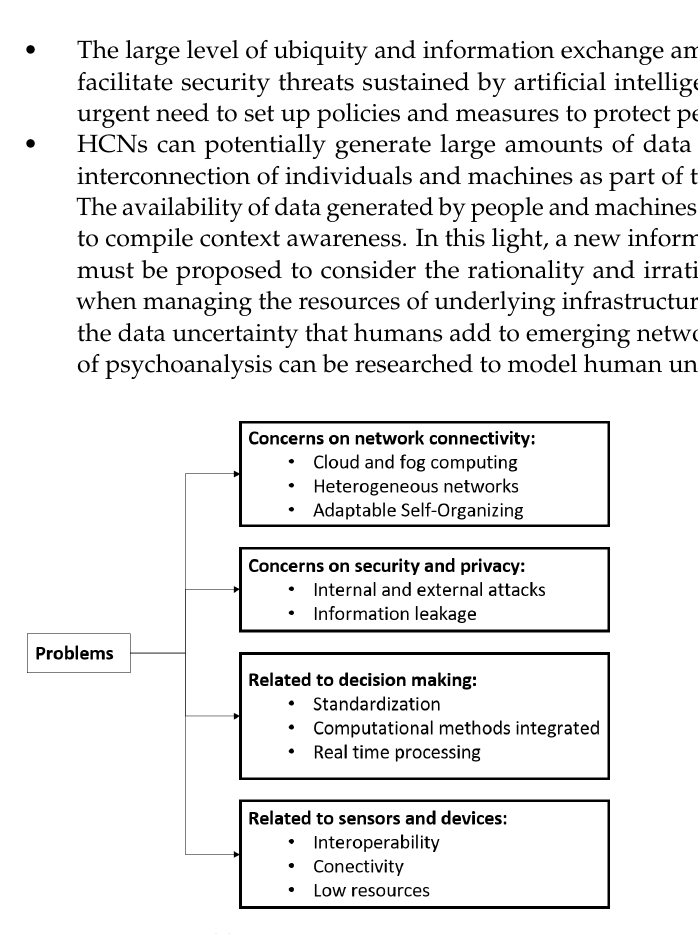
Figure 9. Open problem